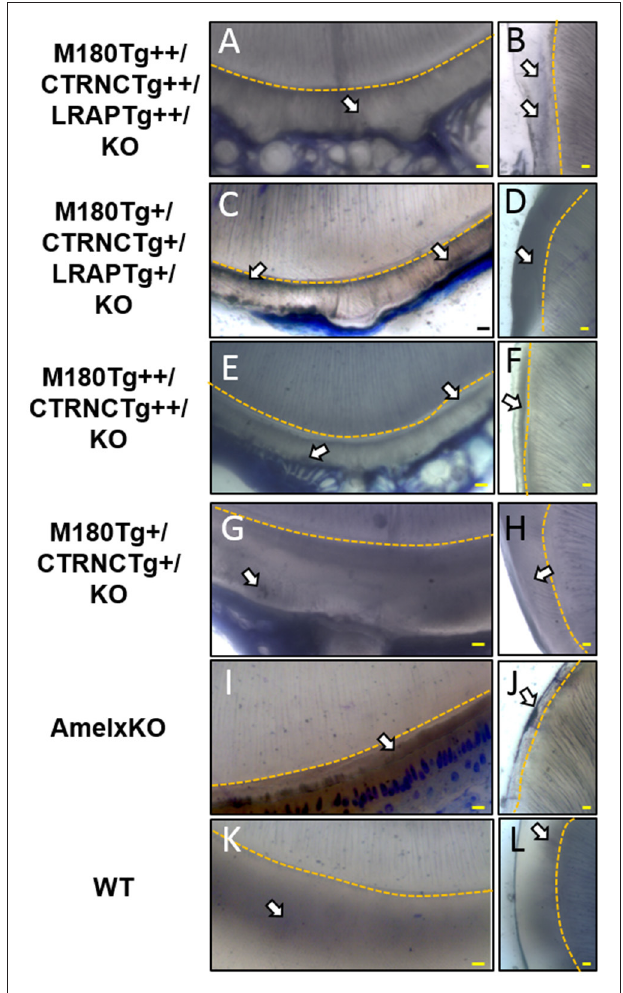
FIGURE 4 | Toluidine Blue staining of LR White embedded samples processed further after SEM analyses. (A,B) Homozygous triple transgenic enamel M180Tg/CTRNCTg/LRAPTg/KO ++ , (C,D) hemizygous triple transgenic M180Tg/CTRNCTg/LRAPTg/KO + , (E,F) homozygous double transgenic M180Tg/CTRNCTg/KO ++ , (G,H) hemizygous double transgenic M180Tg/CTRNCTg/KO + enamel, (I,J) AmelX null, (K,L) WT enamel. Coronal sections through incisors (first column) and molars (second column). Nuclei and organic matter stained blue and marked by arrows, DEJ highlighted in yellow. Scale bars, 10 µ m. Magnification